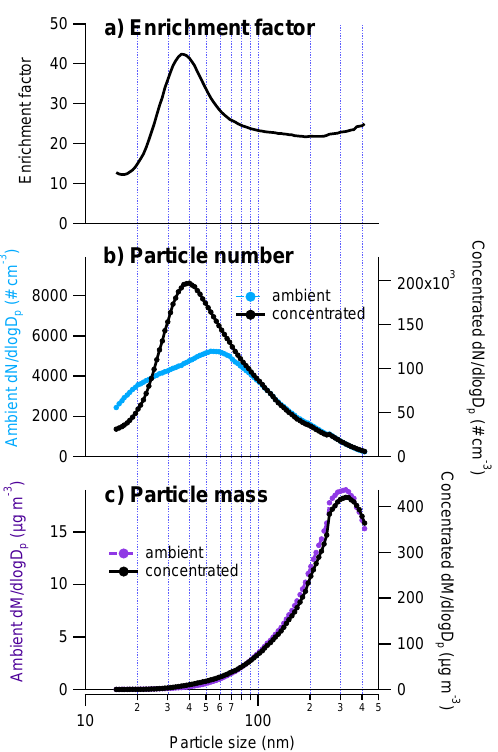
Figure 4. Size distributions for enrichment factor (a) , ambient and concentrated particle number (b) and mass (c) measured with the SMPS. Particle mass was calculated by using the density of 1.48gcm − 3